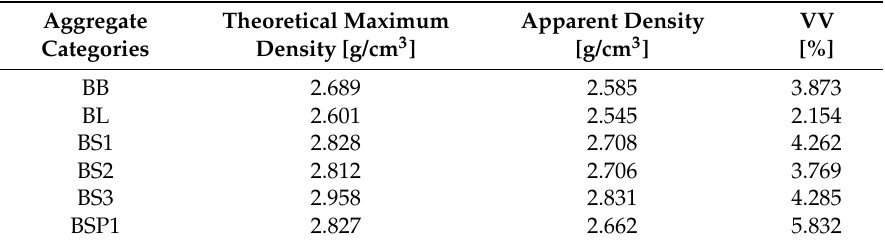
Table 12. Volumetric properties with different coarse